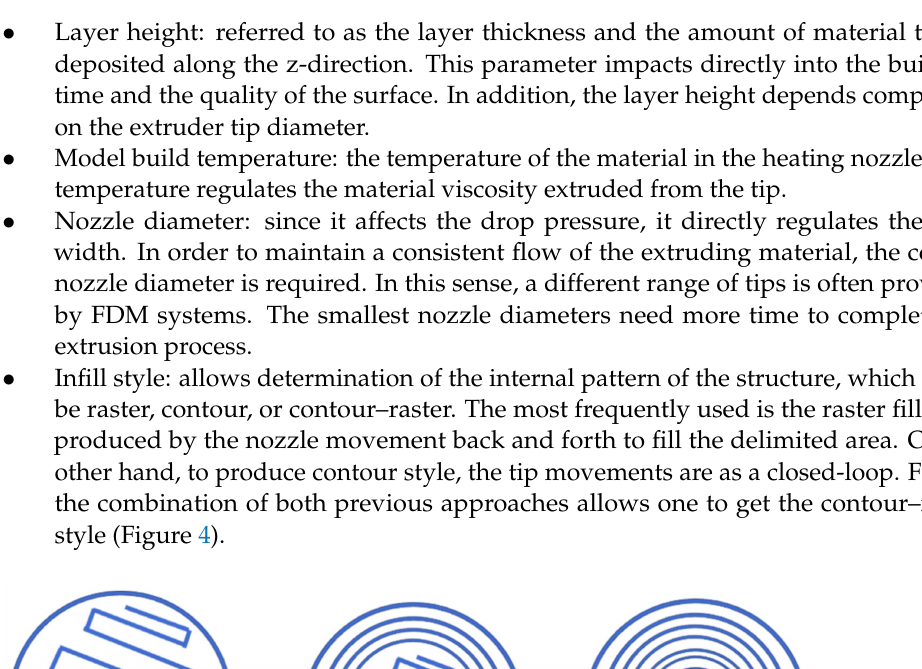
Figure 3. Build orientation.